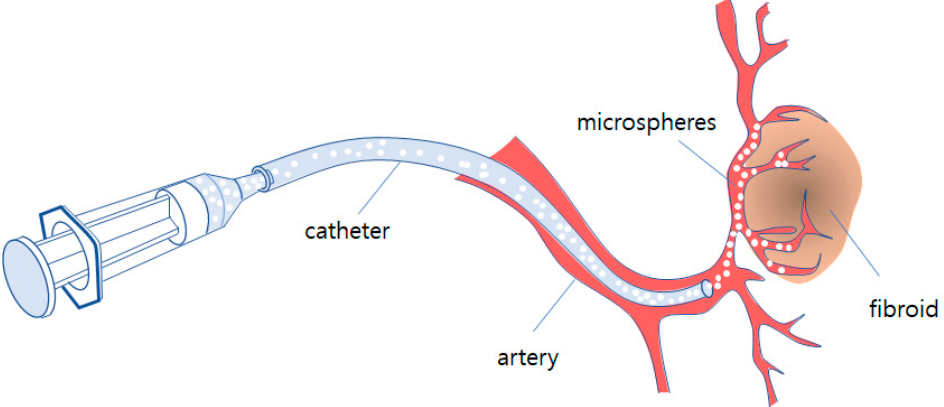
Figure 1. Schematic of fibroid embolization of microspheres with catheter.